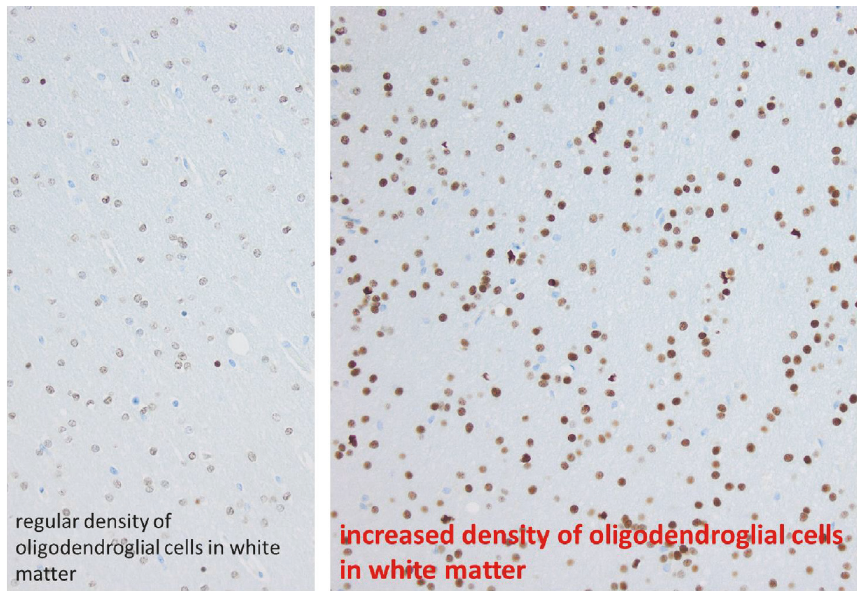
Figure 4: Olig2 immunohistochemistry (oligodendroglial cells are